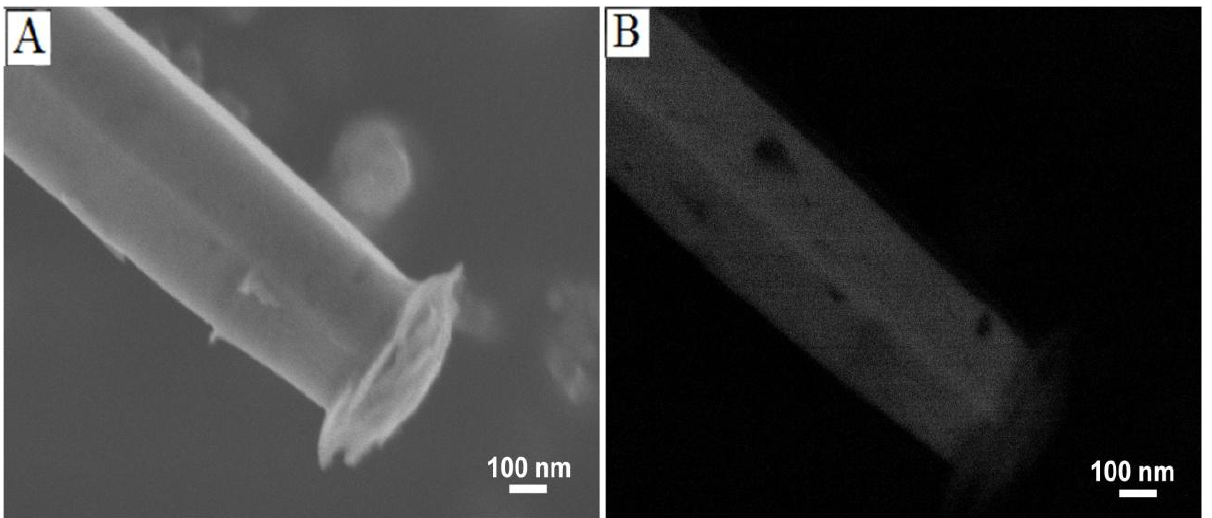
Figure 2. SEM of a ZnO microrods obtained using secondary electrons ( A ) and backscattered electrons; ( B ) show a difference in contrast between the microrod and the cap indicating a difference in electron density or crystal